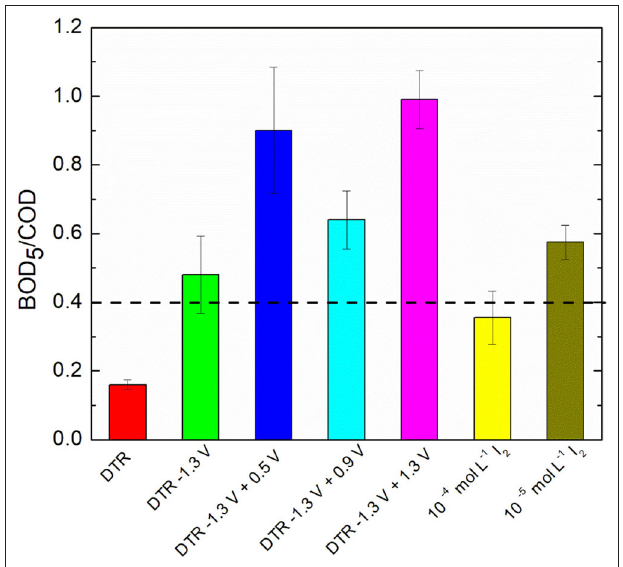
FIGURE 9 | BOD 5 /COD ratio of DTR before and after electrochemical treatments and I 2 solutions in 0.1mol L − 1 Na 2 SO 4 . Error bars are based on duplicate experiments.